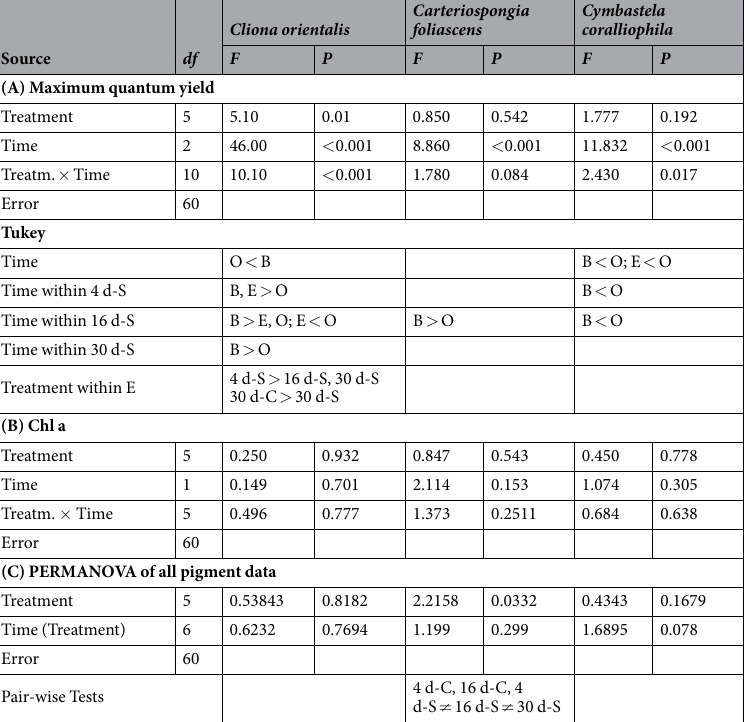
Table 2. ANOVA tables and summaries of linear mixed models of the effects of smothering on the photosymbionts. (A) The effects of treatment and time on maximum quantum yield throughout the experiment with Tukey tests performed for significant pairwise multiple comparisons, (B) The effects of treatment on Chl a concentrations across time (at the end of the experimental (E) and observational (O) periods) and treatment, with Tukey tests performed for significant pairwise multiple comparisons, and (C) Two-way PERMANOVA of all pigment data (Chl a, b, c, d, total Chl and carotenoids) with sediment treatment and time as factors, for the 3 phototrophic species (sediment treatments: 4, 16 and 30 d smothered vs.